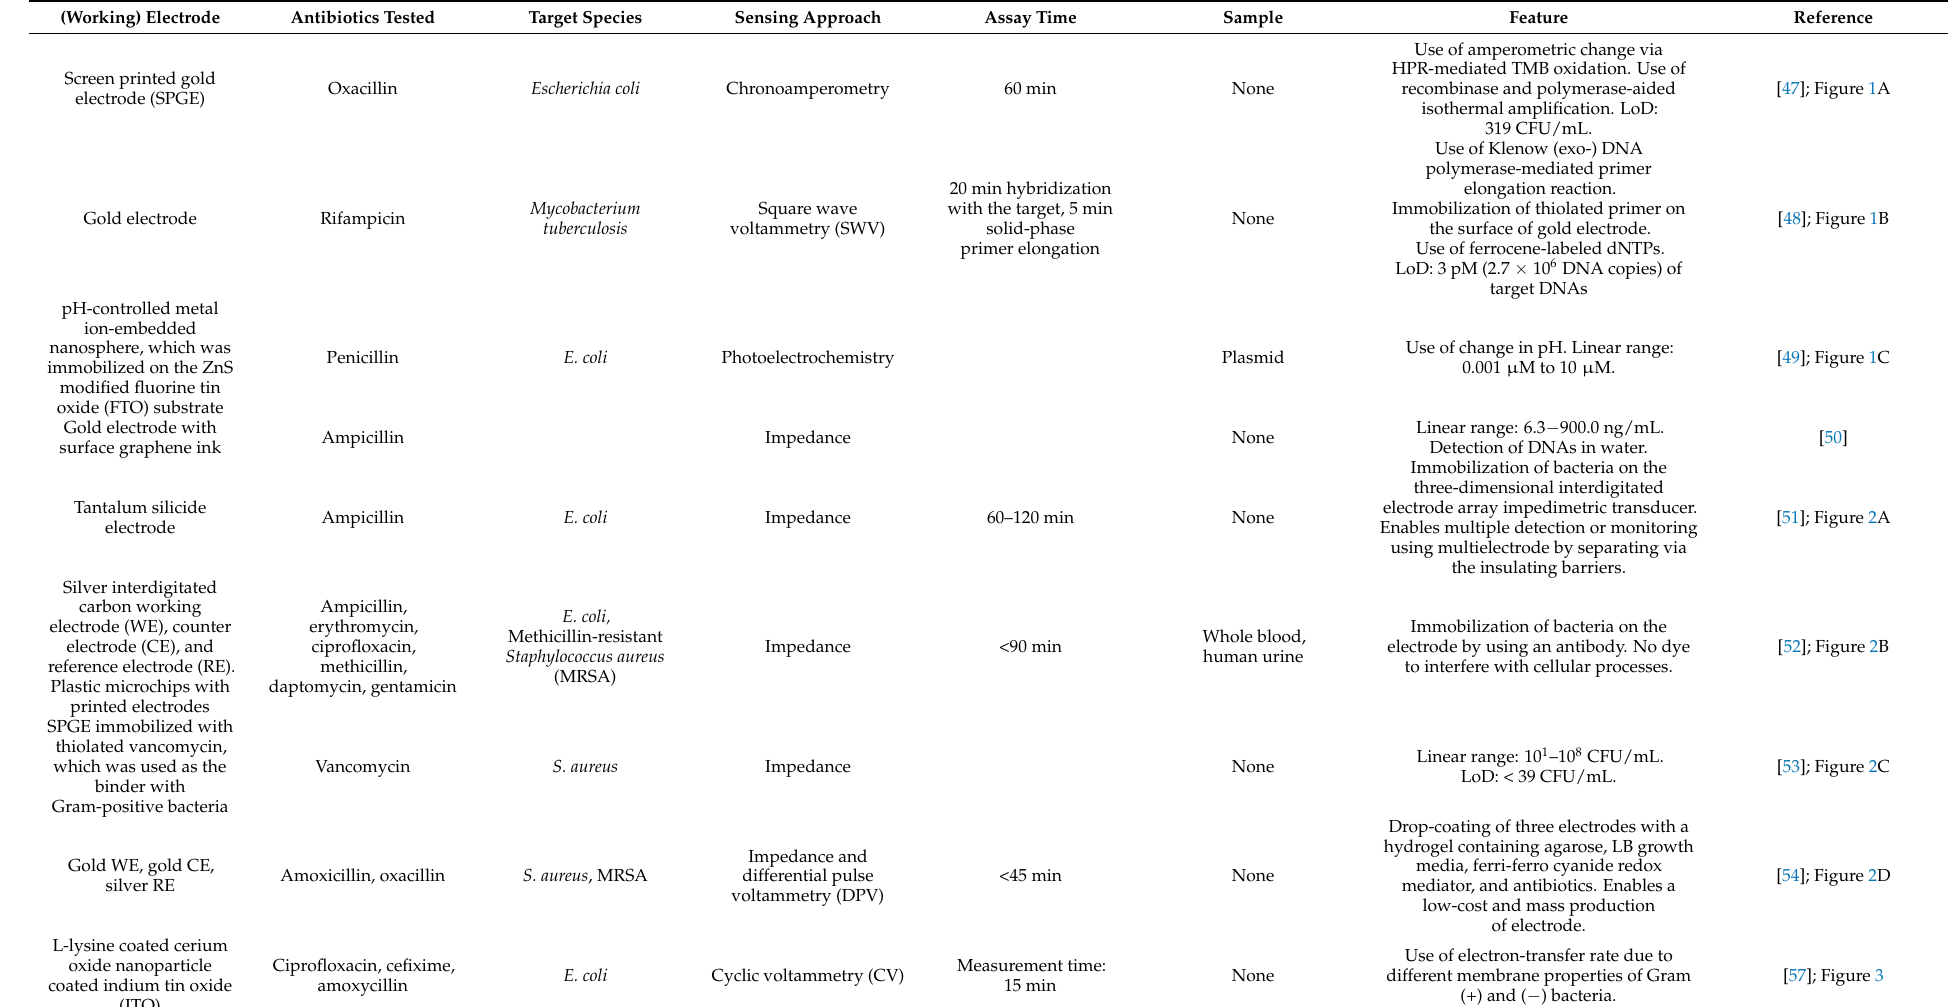
Table 1. Examples of electrochemical sensors for antibiotic resistance/susceptibility testing a